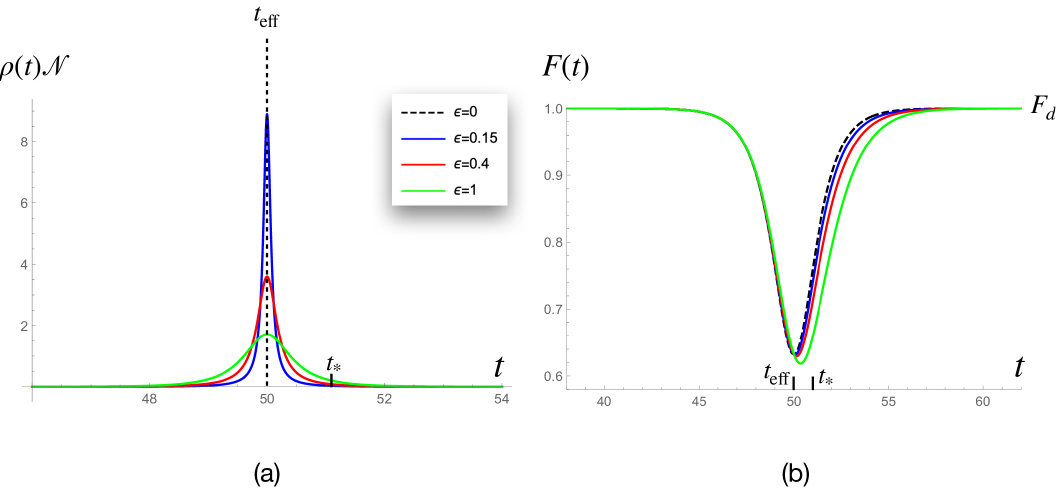
= 1 , c = 2 , t = 50 and t = 51 . For d 1 eff ∗